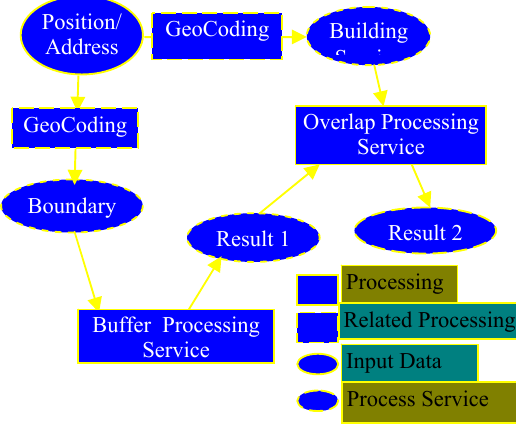
Figure 4. Business detail model of